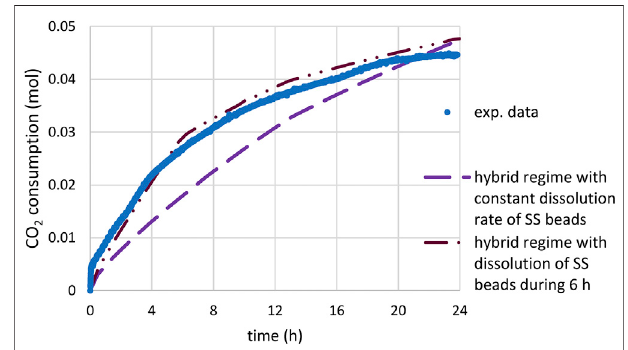
FIGURE 15 | Time-CO 2 consumption during slag carbonation (T (cid:2) 180 ° C, P CO2 (cid:2) 20 bar) under attrition with stainless steel beads: comparison of experimental data and prediction of the mixed model starting under kinetic control and ending under diffusion control below a given critical radius R crit (15 µm); calculations using the PSD of feed material, k ref multiplied by a factor 5 and D eH + equal to 1.3 × 10 – 11 m 2 s − 1 . Iron leaching from the beads is assumed to occur throughout the reaction or during the fi rst 6 h